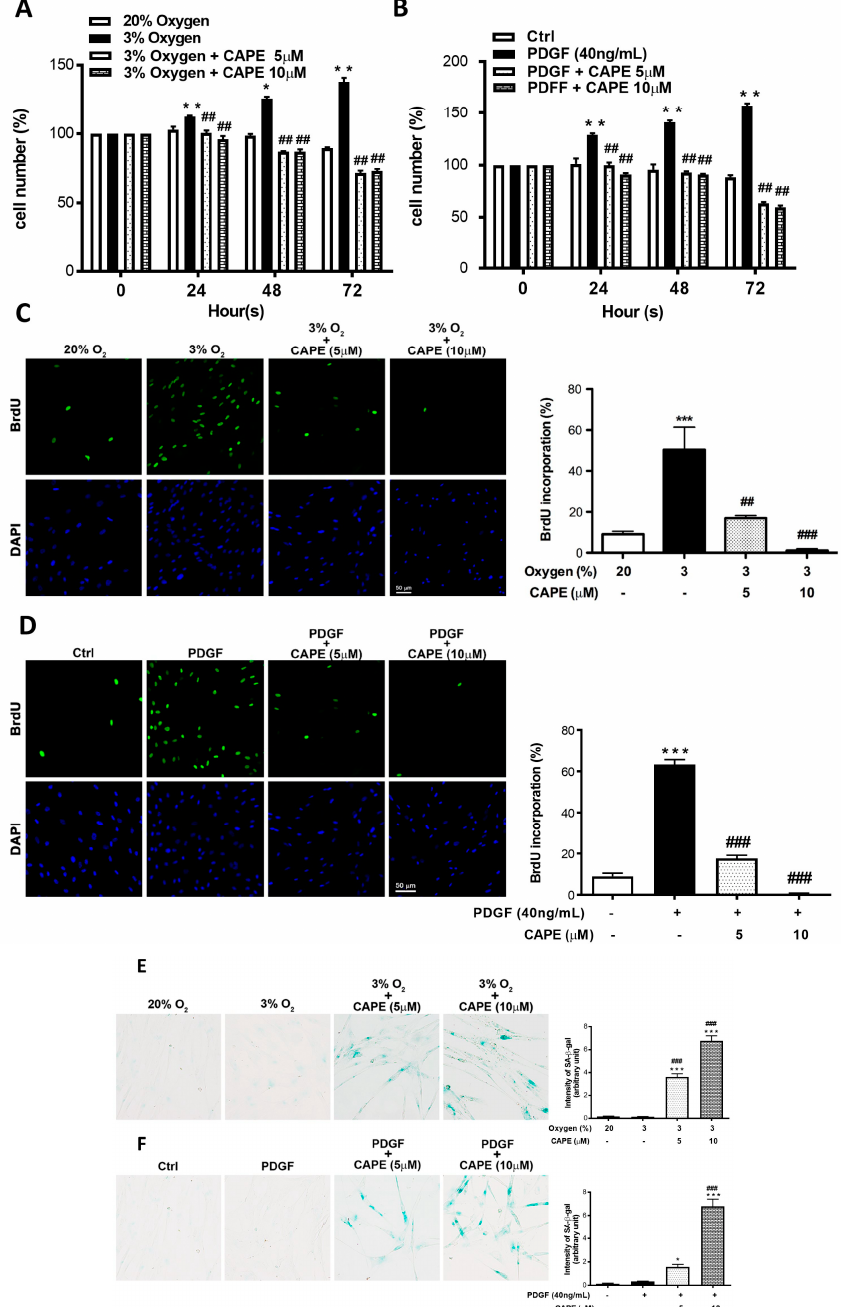
Figure 5. CAPE inhibits hypoxia- and PDGF-BB-induced cell proliferation and increases SA- β -gal activity of human PASMCs. ( A,B ) Cells were pretreated in the absence of inhibitor or with CAPE (5 or 10 μ M) for 2 h, and then were cultured for the indicated times in normoxia (20%), hypoxia (3%), or PDGF-BB. Cell viability was determined by 3-(4,5-Dimethylthiazol-2-yl)-2,5-diphenyltetrazolium bromide (MTT) assay. ( C,D ) Cells were pretreated in the absence of inhibitor or with CAPE for 2 h, and then were cultured for 24 h in normoxia (20%), hypoxia (3%), or PDGF-BB. The proliferation of human PASMCs stained with BrdU/DAPI. All cell nuclei were stained with DAPI in blue, and the dividing cells were immunostained with anti-BrdU antibody in green. The percentage of BrdU-positive cells was presented. Scale bars, 50 μ m. ( E,F ) SA- β -Gal staining of human PASMCs cultured for 24 h in normoxia (20%) or hypoxia (3%) with or without CAPE (5 or 10 μ M). Photography images and quantification of SA- β -Gal positive cells are shown. Values are the mean ± SEM of three independent experiments. * P < 0.05; ** P < 0.002; *** P < 0.001, as compared with the control group. # P < 0.05; ## P < 0.002; ### P < 0.001, as compared with the cells exposed to hypoxia or PDGF-BB.